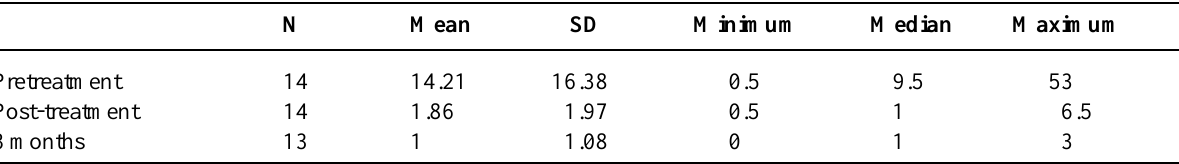
Table 4 – Pad test